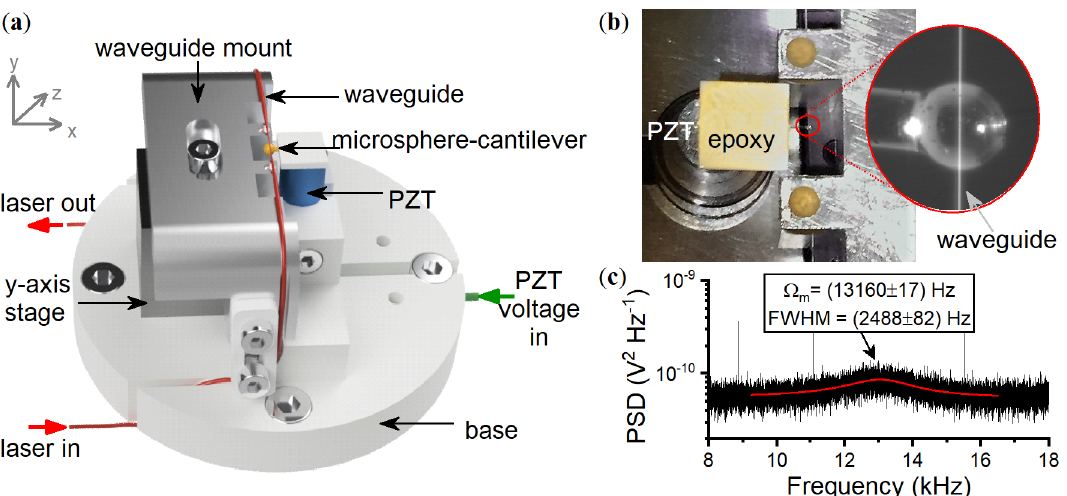
Figure 2. ( a )Not-to-scalerenderingoftheWGMsensorcomponents. ( b )Photoofthemicrosphere-cantilever and tapered waveguide with an inset microscope image. ( c ) The power spectral density (PSD) of the WGM sensor transmission showing the fundamental mechanical mode of the microsphere-cantilever at